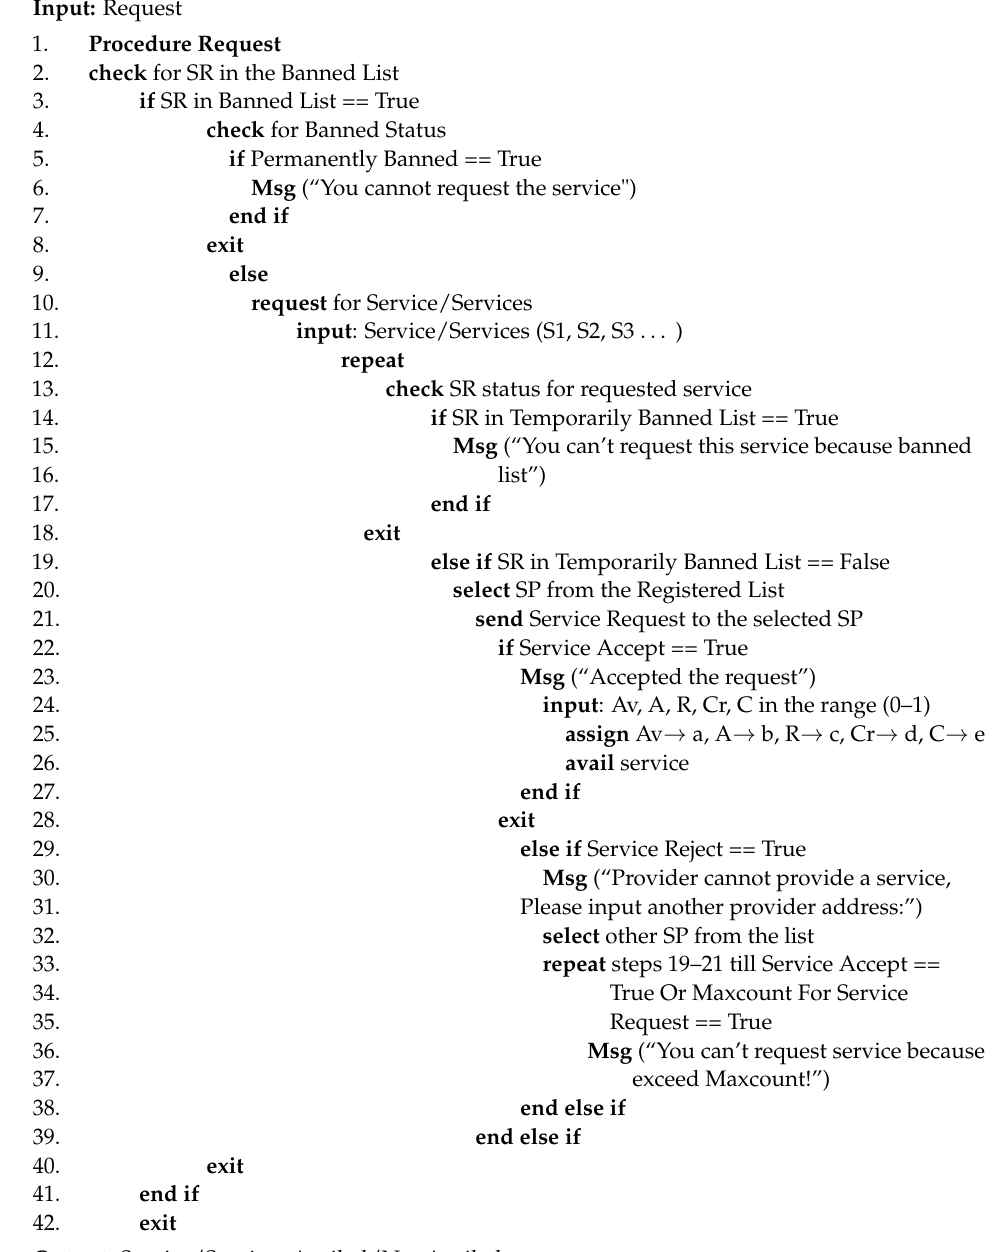
Algorithm A2 Algorithm for Requesting